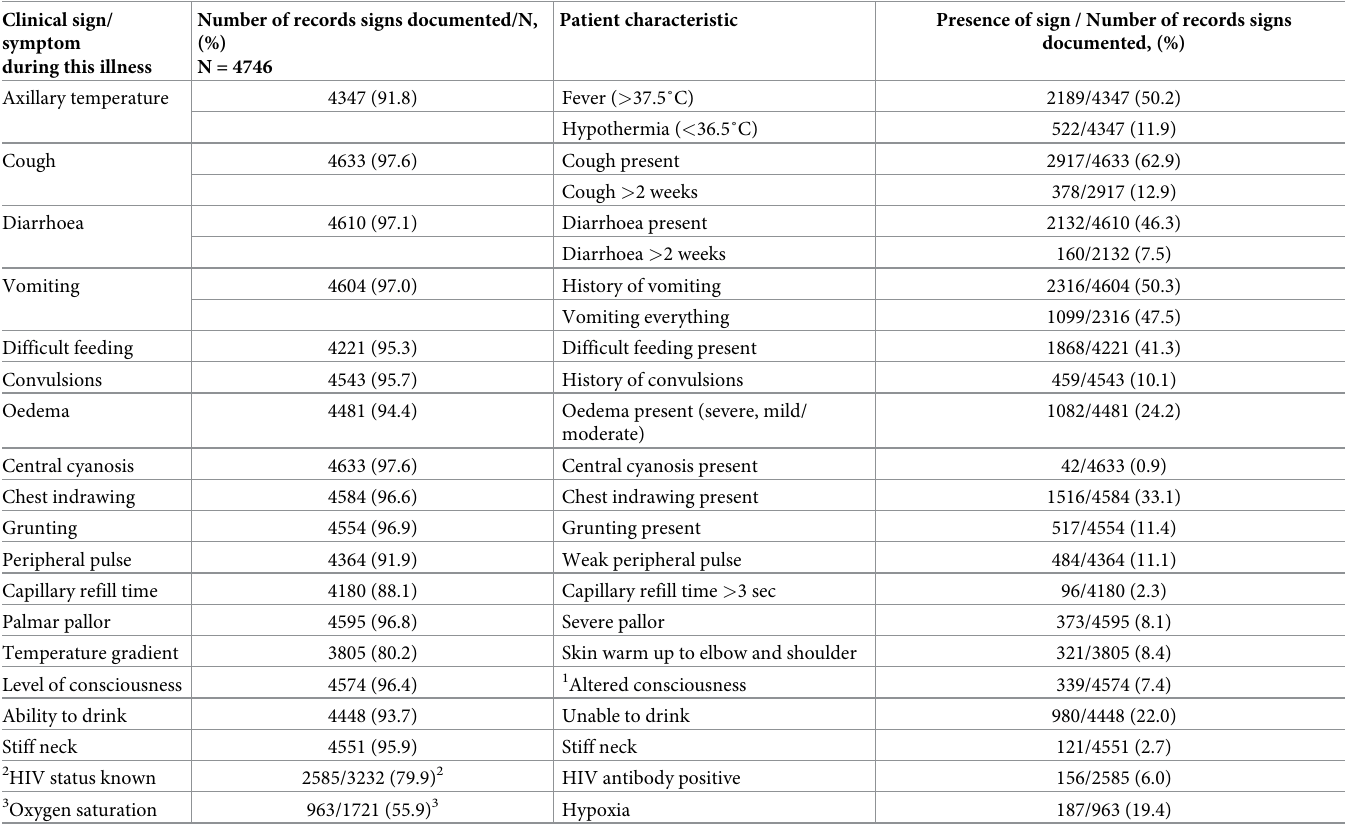
Table 3. Documentation of signs and symptoms important in the assessment and management of paediatric severe acute malnutrition among children aged 6–59 months: April 2014-November 2016. Clinical sign/ Number of records signs documented/N, symptom during this illness